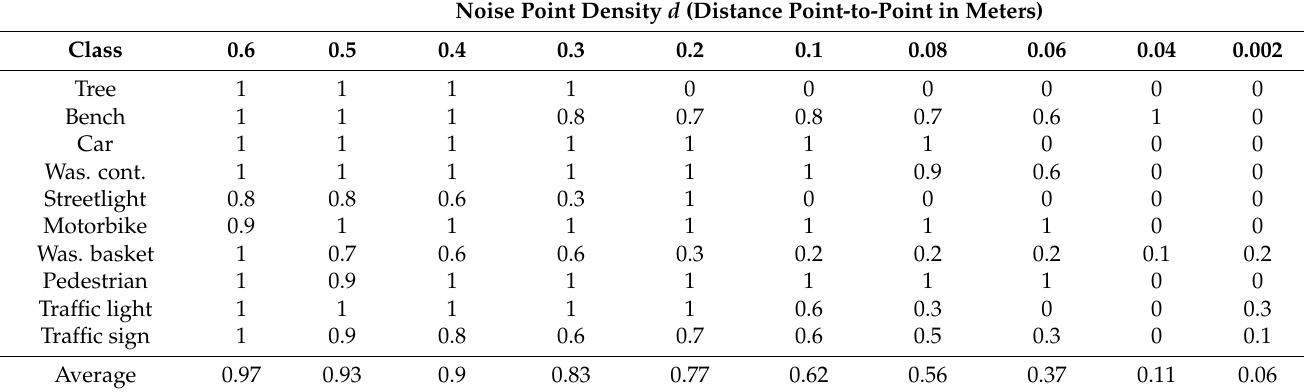
Table 7. Recall of classification with different levels of